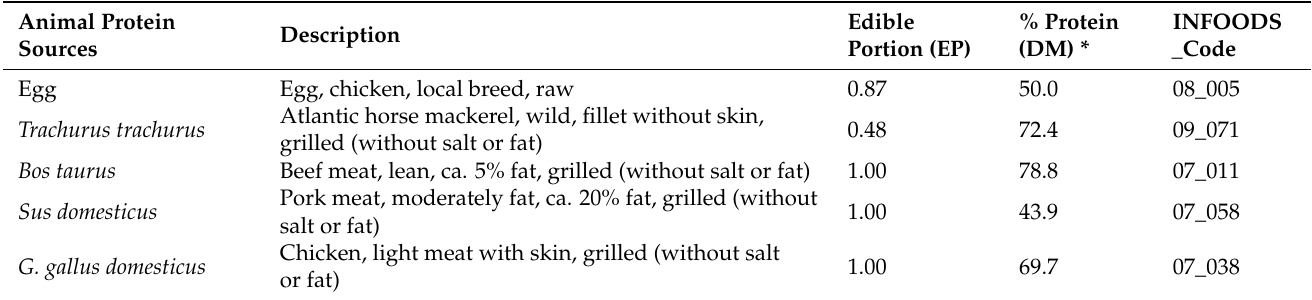
Table 2. Protein content on dry matter basis for selected food sources of animal origin.